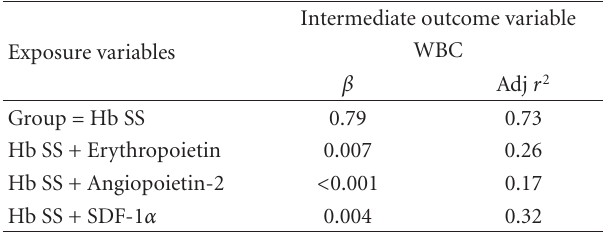
Table 6: Multivariate linear regression showing relationship between Hemoglobin SS group, angiogenic growth factors, and WBC. Each angiogenic growth factor was strongly associated with the relationship between Hemoglobin SS and WBC. Significant reductions in the beta-coe ffi cient ( > 25%) compared to the main exposure are marked with an asterisk ( ∗